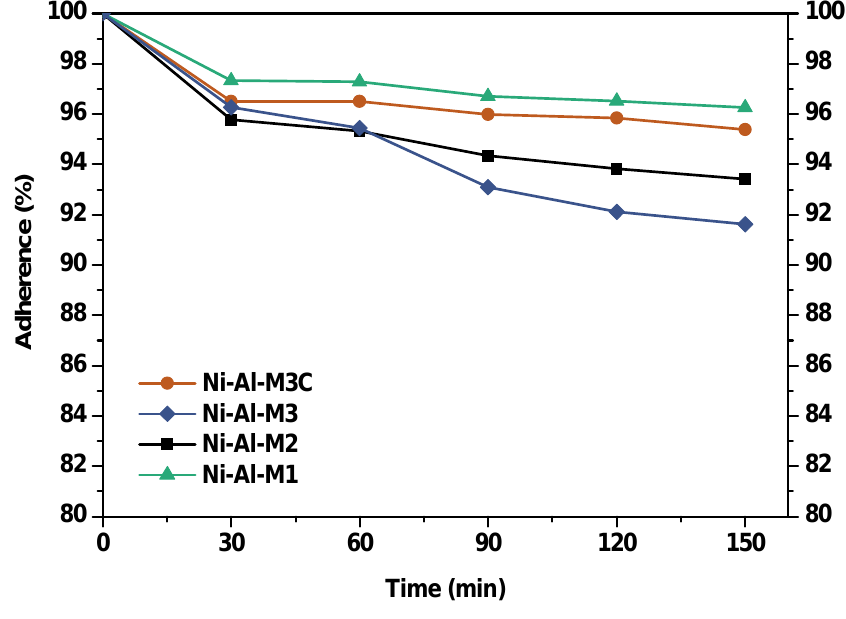
Figure 2. Adherence tests applied to the structured catalysts.